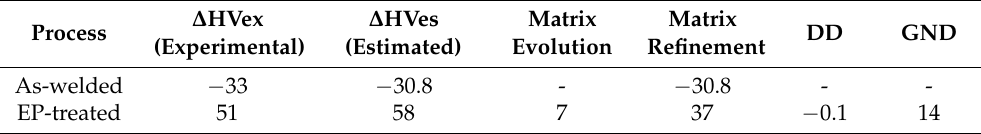
Table 3. Hardness evolutions due to welding and EPT.